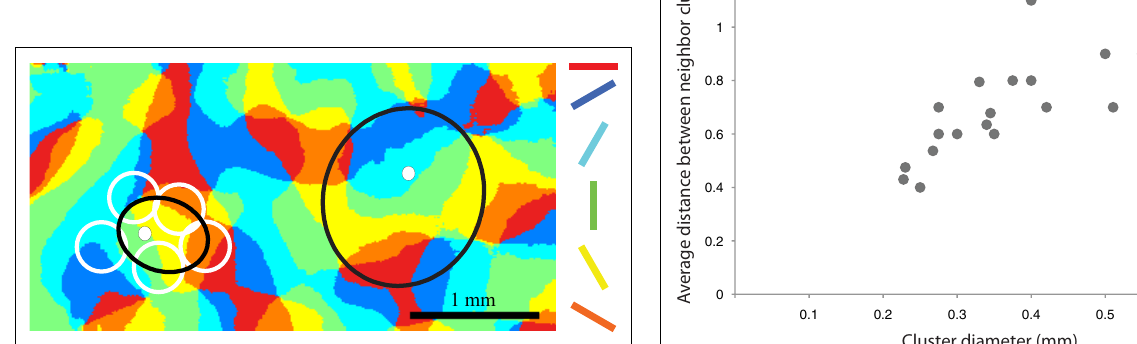
FIGURE 3 | Spread of proximal boutons over multiple orientation domains. The proximal clusters of neurons in layer 2, 3 and 6 can overlap with dendrites of functional domains representing orthogonal orientations. Proximal cluster of two layer 2/3 pyramidal neurons (black ellipse, the cell body is shown as a white dot) superimposed on an orientation map of area 17. Each region of area 17 is color-coded for its preferred orientation. The white circles surrounding the left cluster represent the coverage of a typical dendritic arbor.